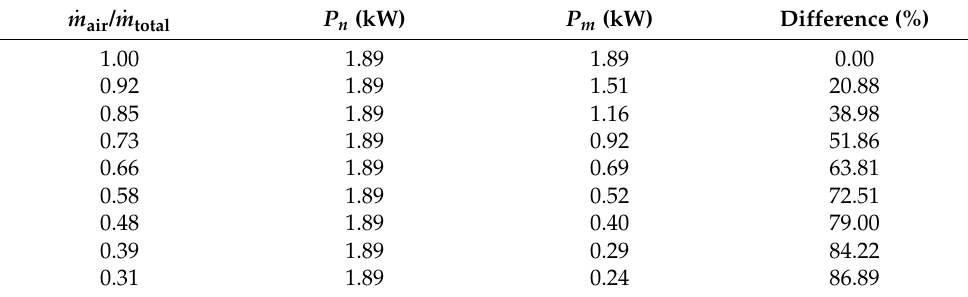
Table 2. Current electric reduction with modification of the air mass flow.